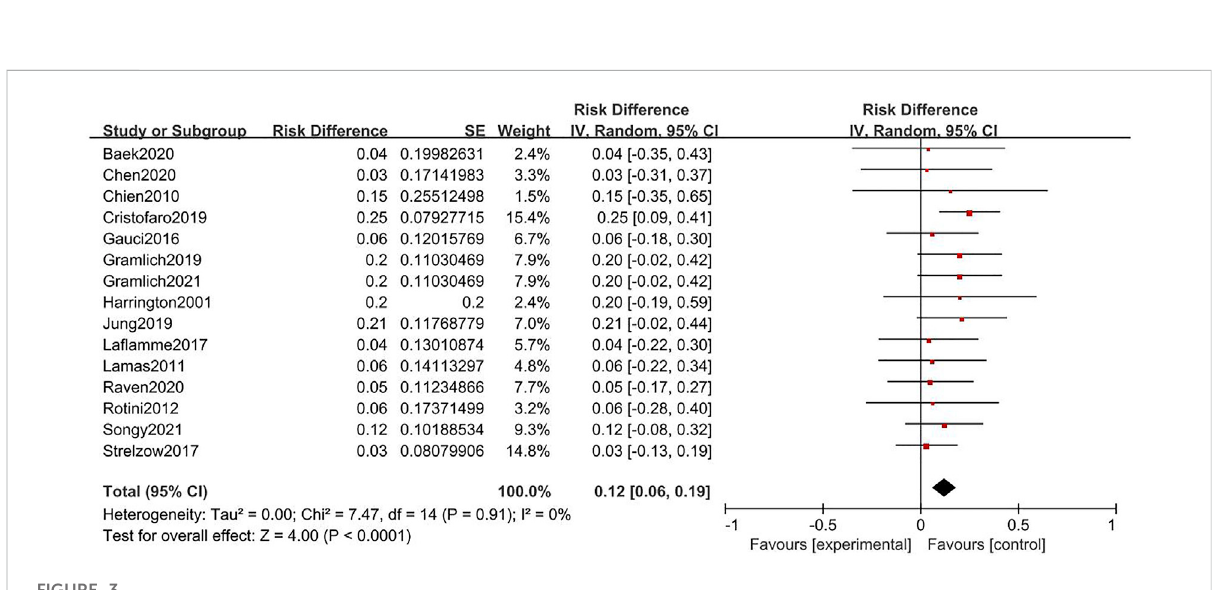
FIGURE. 3 Forest plot for rate of reoperation of uncemented fi